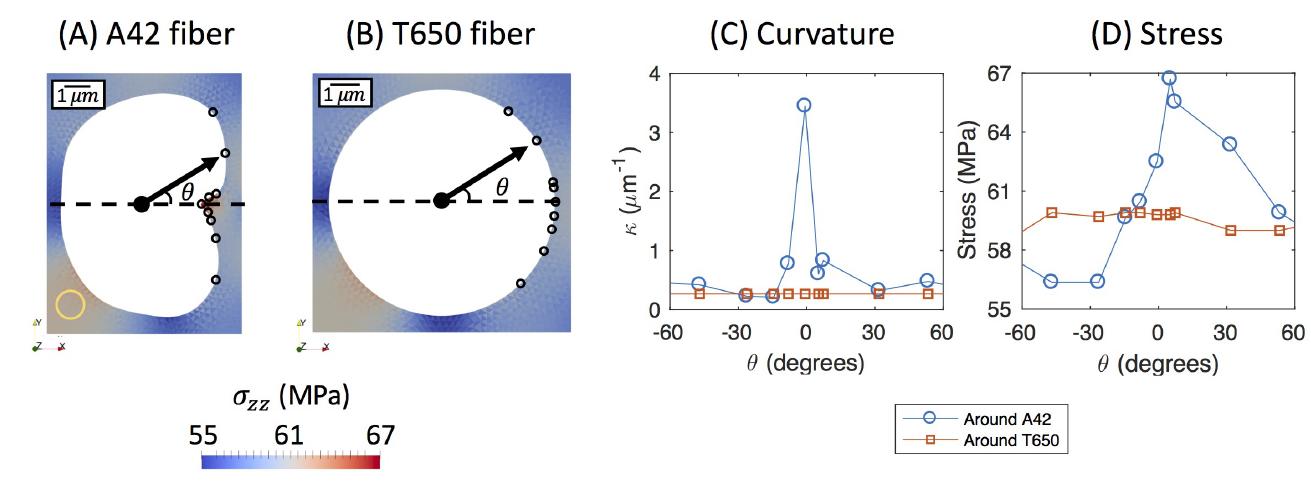
Figure 4. The curvature and stress comparisons of a single fiber model, where ( A ) is the matrix stress around a representative A42 fiber taken from the SEM image, ( B ) is the matrix stress around an ideal T650 fiber, ( C ) is the curvature compared for both fiber models, and ( D ) the stress compared for both fiber models. The yellow circle in ( A ) shows the effects of the roller boundary conditions at the − X and − Y